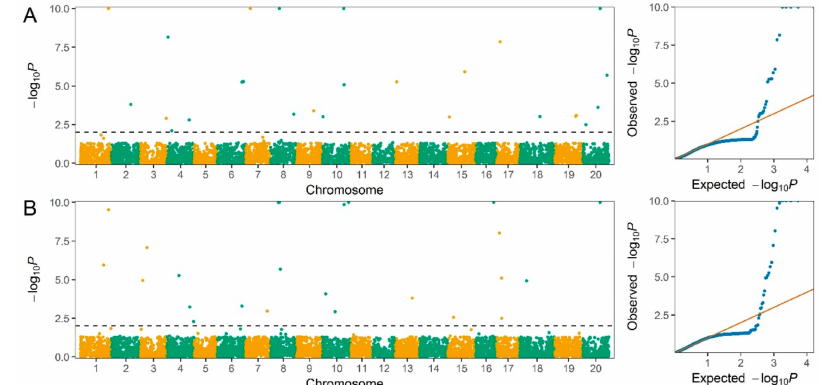
Figure 2. Manhattan and quantile-quantile plots illustrating GWAS for seed protein content ( A ) and oil content ( B ) based on SNPLDB markers using the RTM-GWAS procedure in the soybean association panel. The horizontal dotted black line indicates the genome-wise significance threshold of 0.01, where the − log P values of SNPLDB markers for seed protein content and oil content range from 2.1 to 56.1 (A) and 2.3 to 55.0 (B), respectively. The − log p values greater than 10.0 are shown as